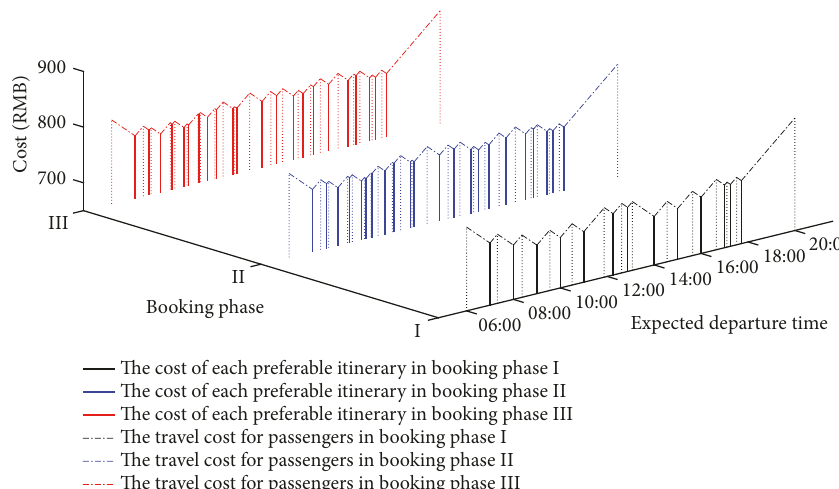
Figure 11: The cost and the expected departure interval of each preferable itinerary in each booking phase from the MBPRA algorithm.